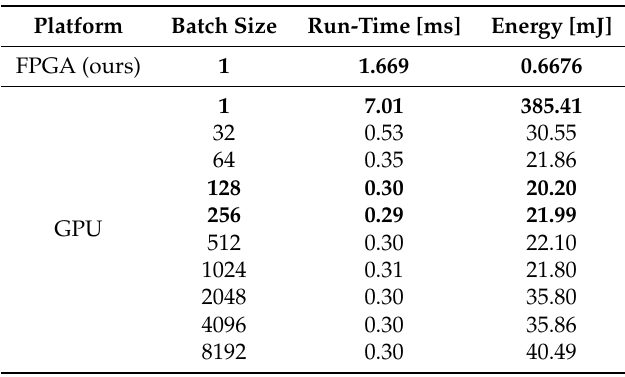
Table 3. FPGA vs. GPU batch performance analysis.